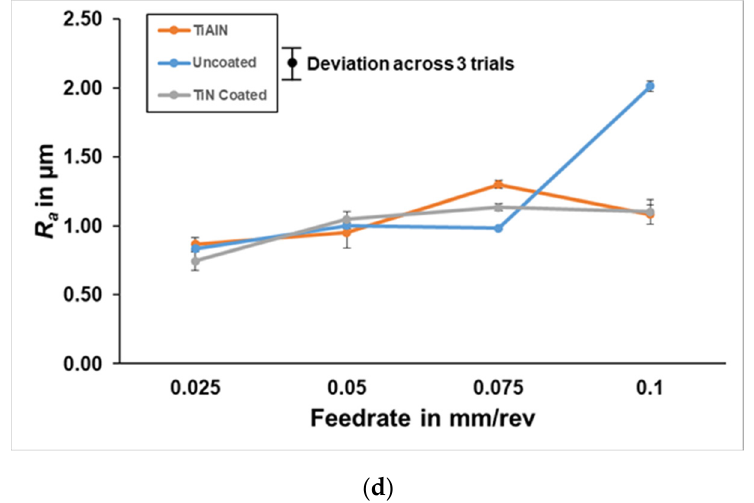
Figure 5. Plots of arithmetic mean surface roughness ( R a ) against feed-rates and depths of cut; ( a ) 0.025 mm/rev feed rate, ( b ) 0.10 mm/rev feed-rate, ( c ) 0.1 mm depth of cut, ( d ) 0.5 mm depth of cut.